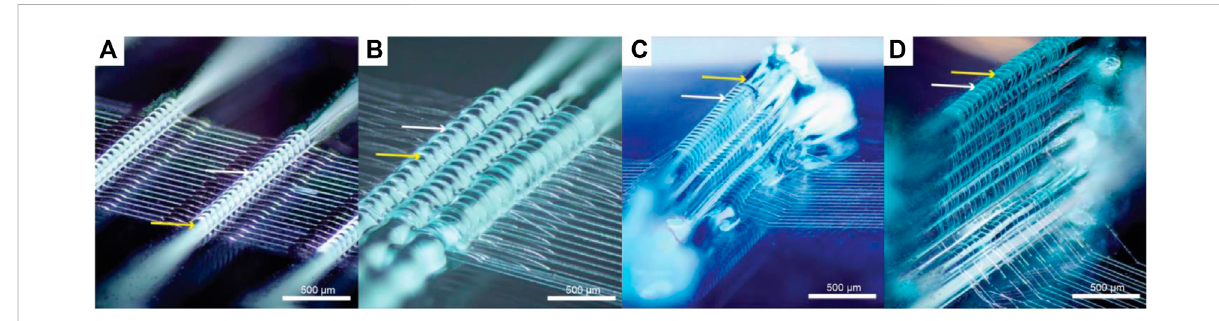
FIGURE 4 Melt electro writing on top of hydrogel strands (Pluronics F127) (Ruijter et al., 2019). Deposited MEW fi bers on a single strand (A) , grouped strands (B) and multiple layers of Pluronics F127 (C,D) . White arrows indicate the melt electro spun PCL fi bers and yellow arrows depict Pluronics F127 strands.